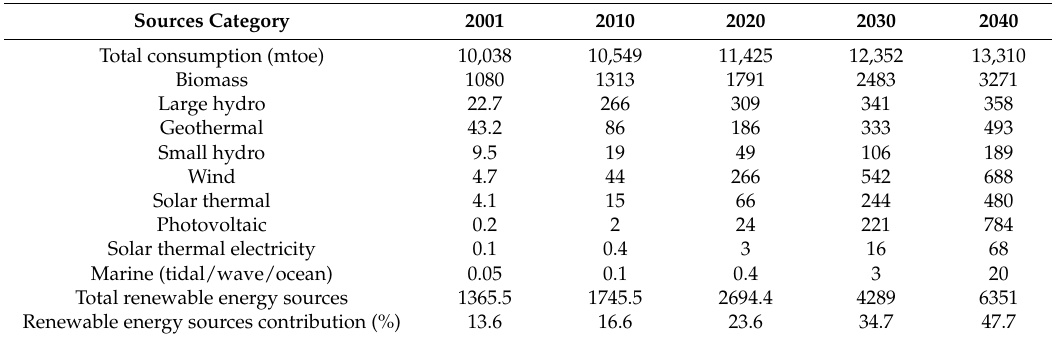
Table 1. Global renewable energy scenario for 2040.